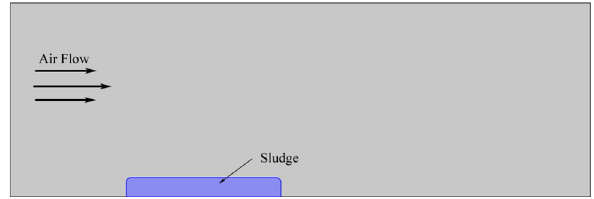
Figure 1. 2D Geometric